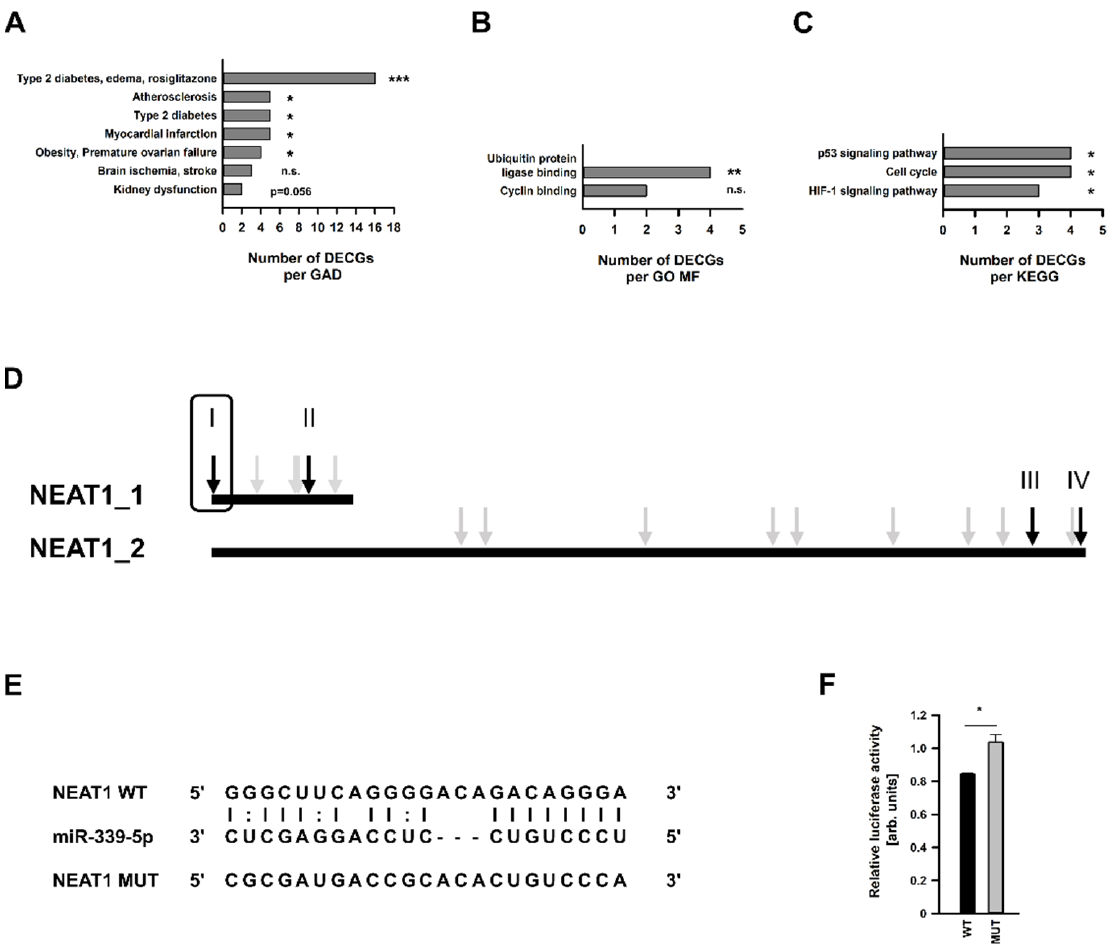
Figure 5. Functional enrichment analysis of differentially expressed coding genes (DECGs) in human mesangial cells (hMCs) with predicted miR-339-5p targeting site. Significant enriched terms in respect of ( A ) Genetic Association Database (GAD) diseases (the complete list is shown in the Supplement), as well as ( B ) Molecular Function (MF). ( C ) Functional enrichment analysis in terms of Kyoto Encyclopedia of Genes and Genomes (KEGG) pathways. Abbreviation: HIF: hypoxia induced factor. Selected significant terms (according to DAVID integrated algorithms) are sorted by count. Additionally, significance regarding actual over-representation of a particular term was analyzed by hypergeometric testing. * p < 0.05; ** p < 0.01; *** p < 0.001; n.s. = not significant. ( D ) Predicted miR-399-5p targeting sites for NEAT1_1/2 indicated by grey and black arrows. Loci marked with black arrows were analyzed via luciferase reporter gene assays. Information and result for the site with the framed black arrow are shown in ( E , F ) in this figure. ( E ) Potential interaction site of miR-339-5p and NEAT1 . The sequences of miR-339-5p, wildtype (WT) NEAT1 and designed mutated (MUT) NEAT1 are shown. ( F ) Dual-luciferase reporter assay in hMCs showing the effect of miR-339-5p cotransfected with pmirGlo vector containing either WT or MUT NEAT1 sequence, displayed by black bar + SD or grey bars + SD, respectively, n = 3–4. DECG (grey bars). Significance was analyzed by Student’s t -test. * p < 0.05.